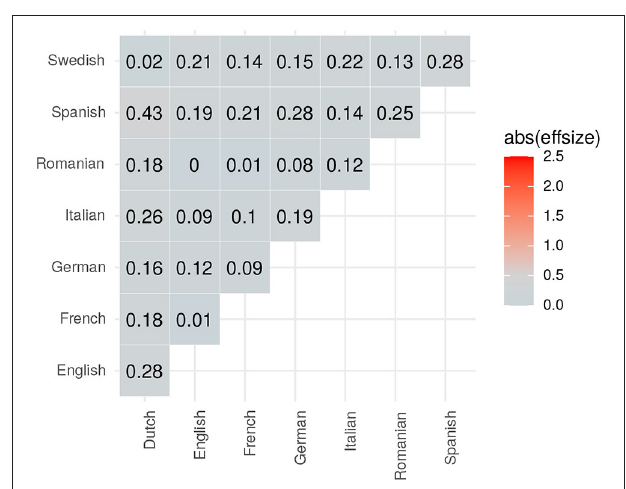
FIGURE 4 | Effect size estimations (Cohen’s d ) for the pseudo-complexity differences in the Brownian Motion simulation.